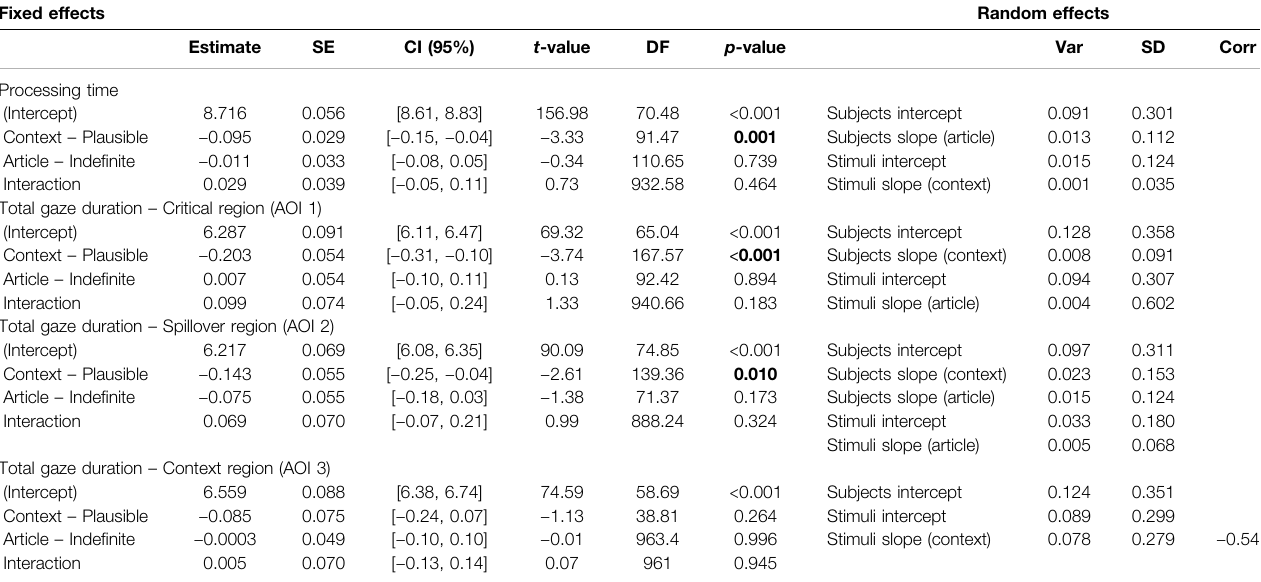
DFstandsfordegreesoffreedom,SEforstandarderror,CIforcon fi denceinterval,Var.forVariance,SDforstandarddeviationandCorrforcorrelation.Valuesinboldaresigni fi cantat p < 0.05 (calculated with Satterthwaite ’ s approximations). The selected mixed effects models are presented in Table 3 .